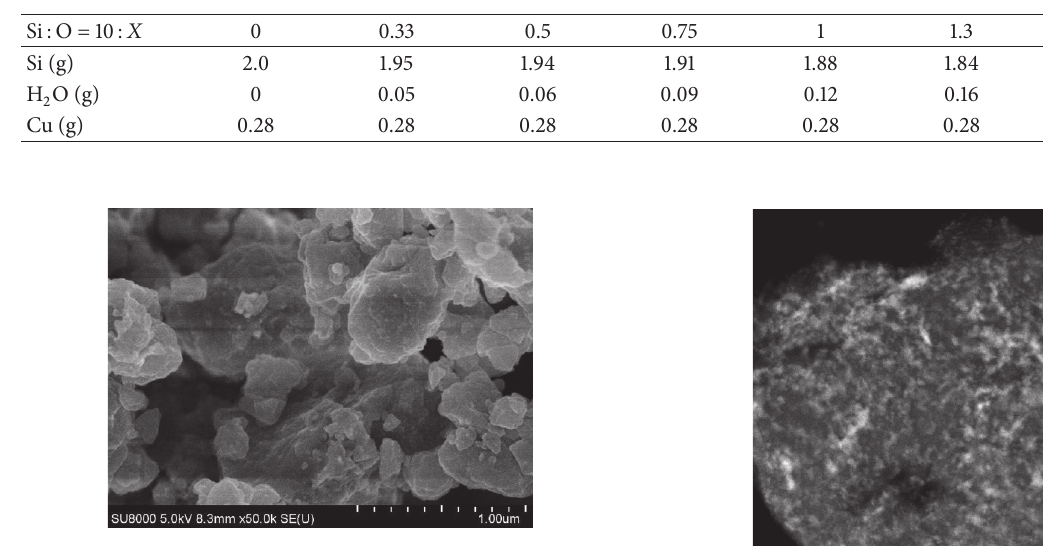
Table 1: Amounts of Si, H 2 O, and Cu used in the grinding process.